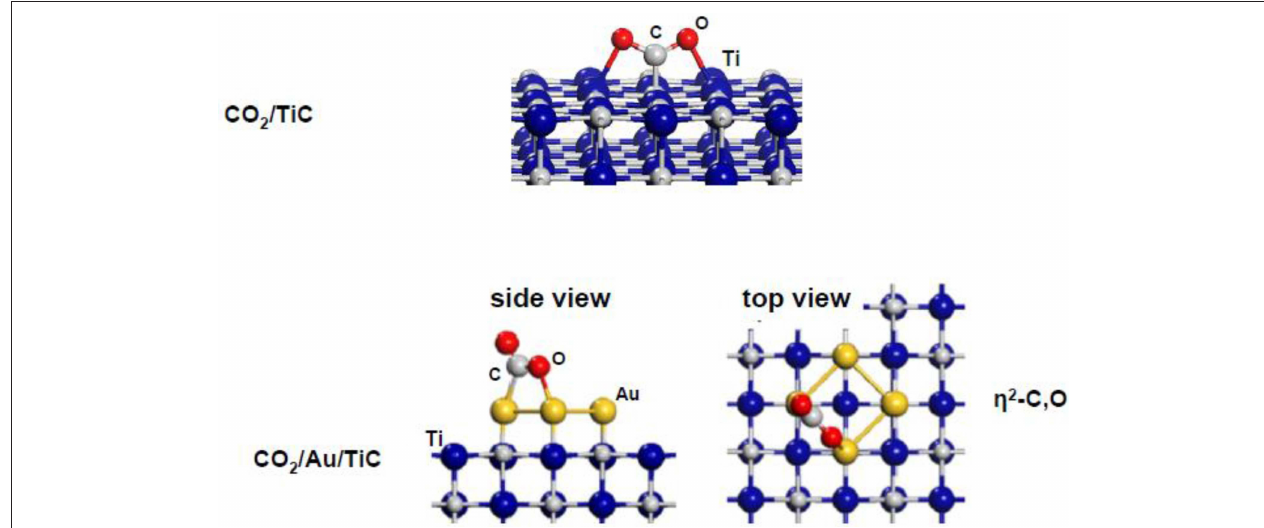
FIGURE 11 | Adsorption geometries obtained with DF calculations for CO 2 on TiC(001) and Au 4 /TiC(001) surfaces. Reproduced with permission from Vidal et al. (2012) , copyright 2012 by the American Chemical Society of Chemistry.